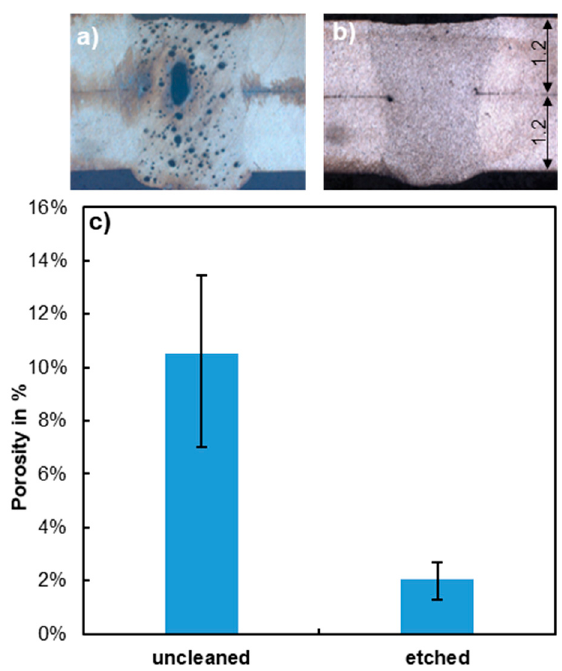
Figure 1. Cross sections of full penetration welds, welded in overlap configuration with a feed rate of 6m / min, a beam diameter of about 500 µ m, and a laser power of 4.5kW in two uncleaned sheets, ( a ), two sheets cleaned by etching, ( b ) their corresponding porosity, ( c ), measured from the ratio between the pores’ area and the total cross-sectional area.